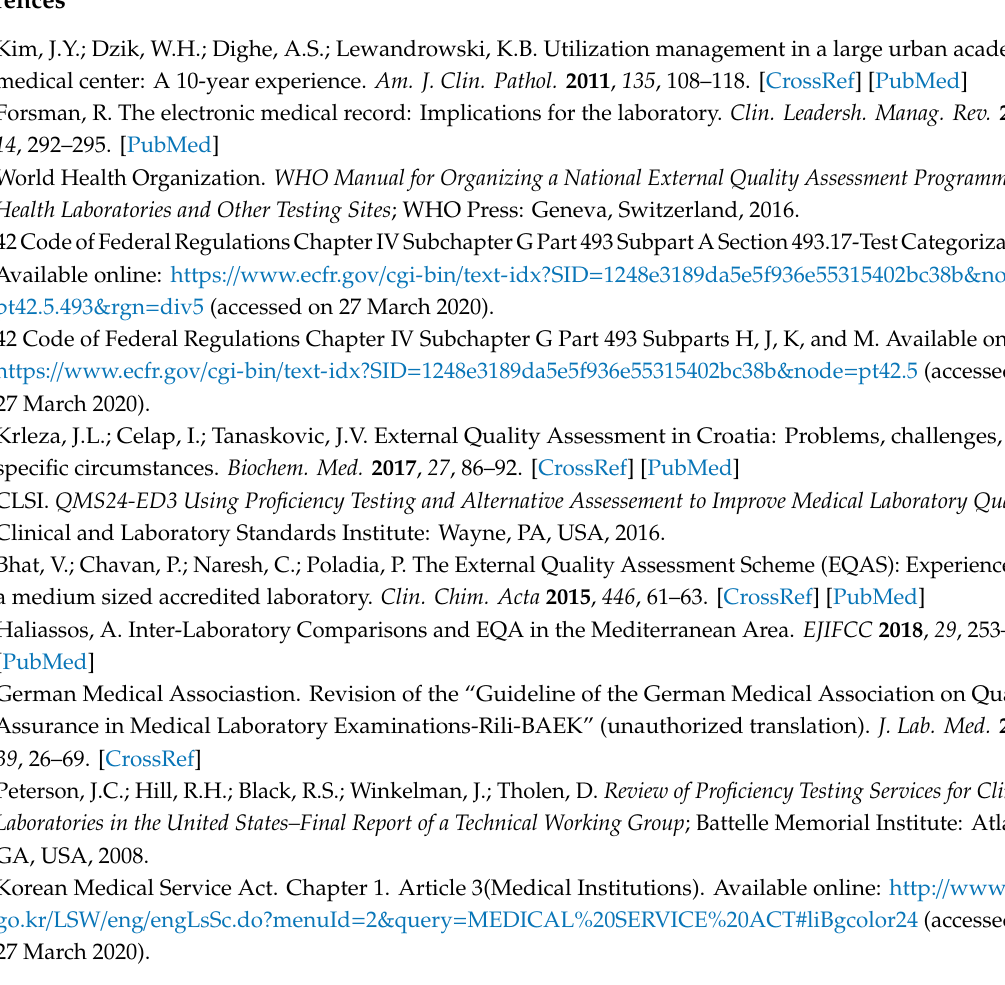
Table S1: List of low-complexity tests, Table S2: The number of medical institutions performing NHIS-supported public health checkups (excluding dental clinics, dental hospitals, and public health centers). Data were from the Korean Statistical Information Service (KOSIS, http: // kosis.kr /